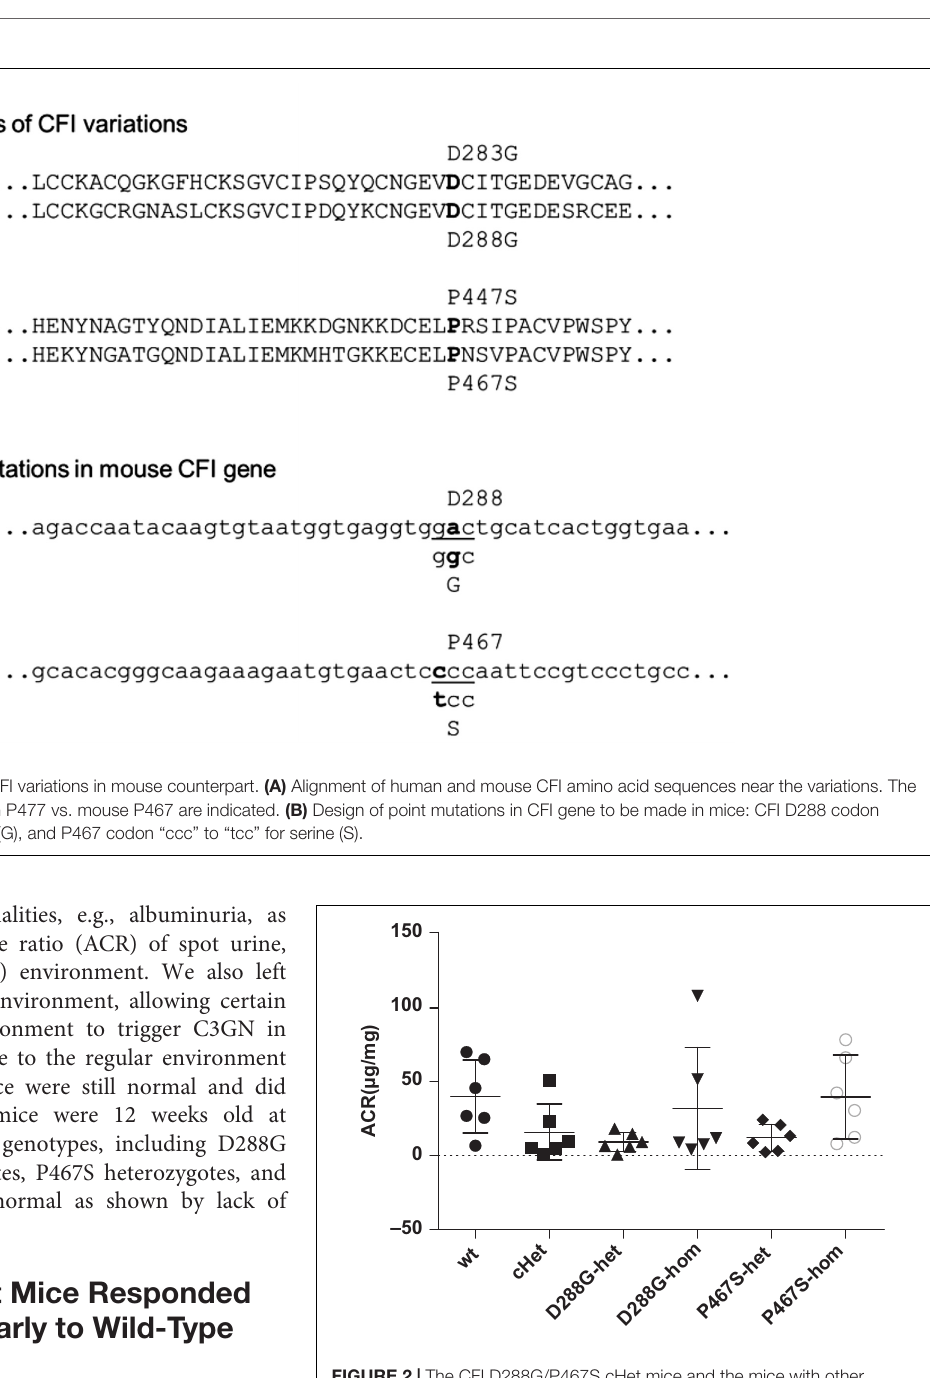
FIGURE 2 | The CFI D288G/P467S cHet mice and the mice with other genotypes did not develop proteinuria spontaneously at the age of 12 weeks. Urinary albumin/creatinine ratio ( µ g/mg) was measured for the mice in the groups of mice as indicated, and they all had a normal level of urinary albumin. Wt, wildtype; cHet, compound D288G/P467S heterozygotes; D288G-Het, D288G heterozygotes; D288G-Hom, D288G homozygotes; P467S-Het, P467S heterozygotes; P467S-Hom, P467S homozygotes. n = 6 for all groups. No statistically significant differences were observed among the groups according to the Kruskal-Wallis test ( p =